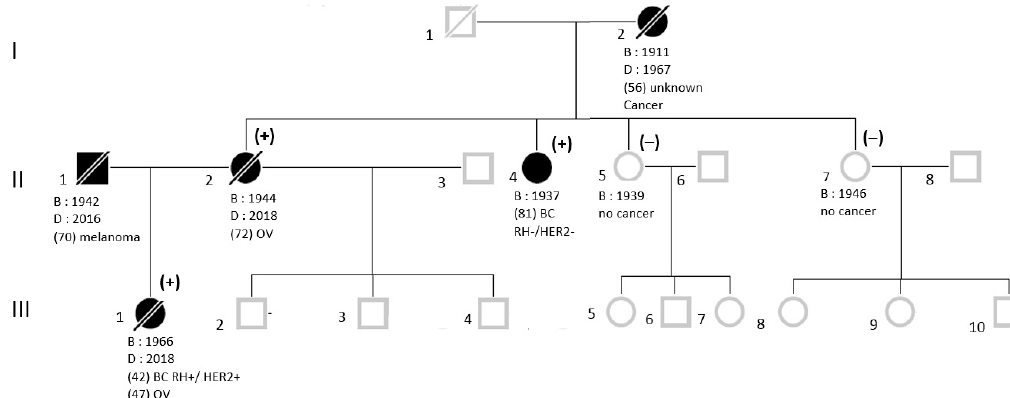
Figure 1. Pedigree of the family assessed for HBOC gene screening. (+): Subject carrying the BRCA1 c.4475_4476ins Alu insertion, ( − ): Subject not carrying the Alu insertion. BC: breast cancer; OV: ovarian cancer; RH: hormone receptors; HER2: human epidermal growth factor receptor 2.